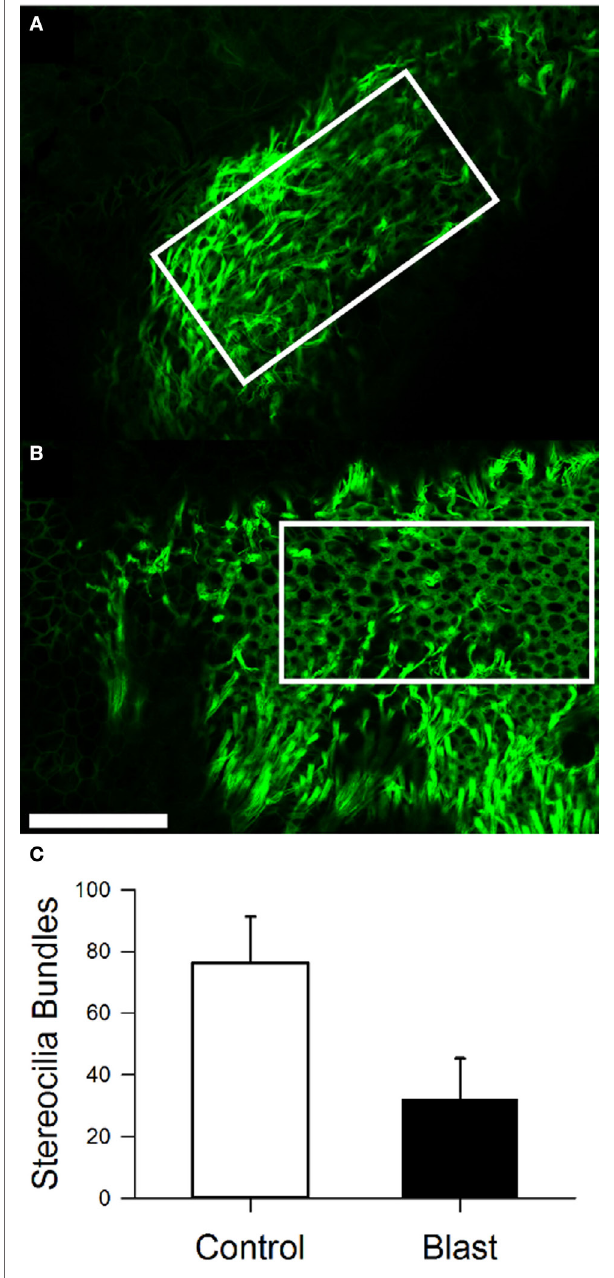
FigUre 8 | Stereocilia bundle loss in the horizontal cristae observed 28 days after blast-wave exposure. Confocal images of the cristae showing stereocilia (phalloidin, green) in control (a) and blast (B) animals 28 days after sham or blast exposure. Rectangle indicates 100 µm × 300 µm counting frame over the central zone of the cristae. (c) Mean bundle counts for control (white) and blast (black) animals. Error bars = SE. Scale bars: 50